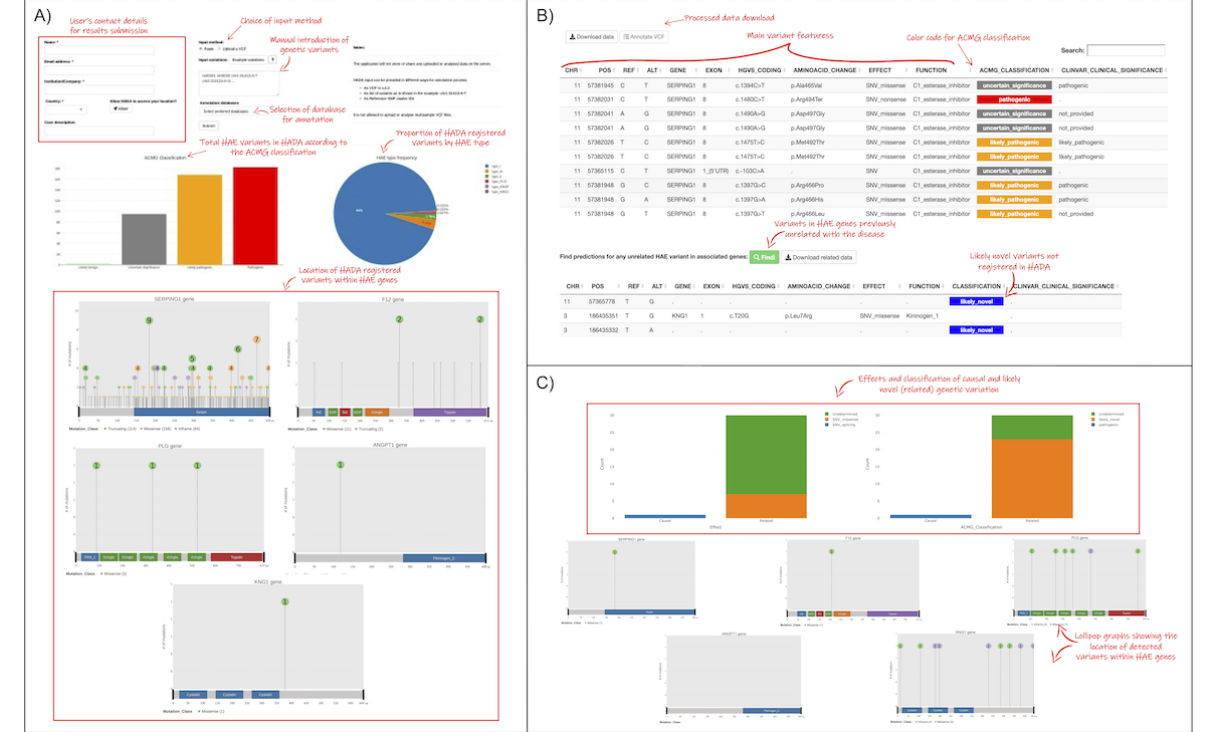
Figure 4. Selected snapshots of the HADA graphical interface with step-by-step instructions. Users can query variants of interest or alternatively upload an individual variant calling file (VCF) in the home page (A). The detected variants tab (B) shows the existence of variants affecting function in the query, as well as other variants in hereditary angioedema (HAE) genes. Plots are also generated and available for users to download